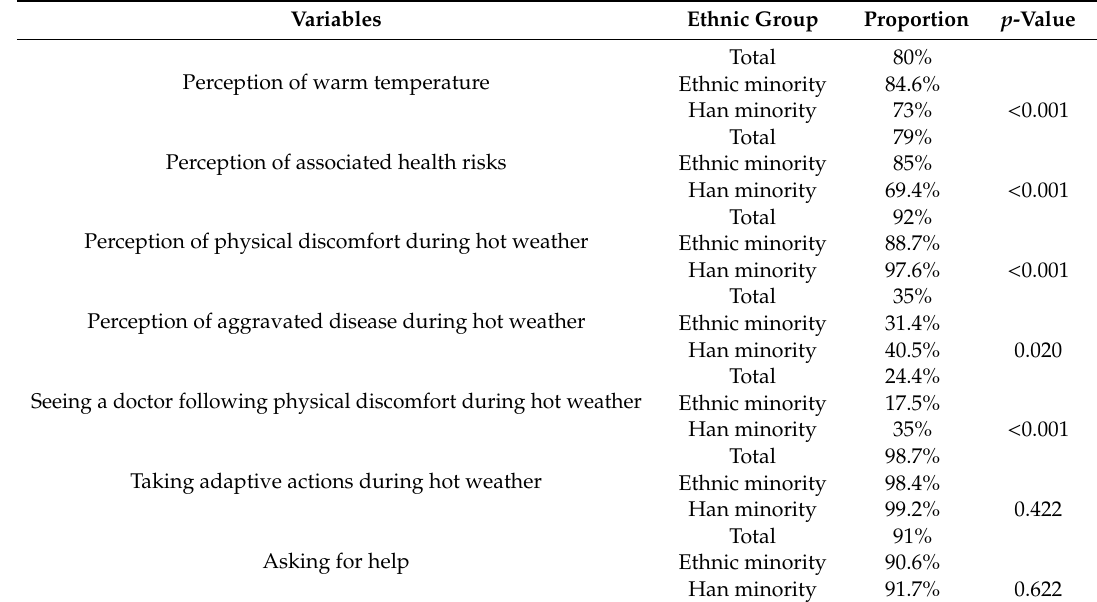
Table 2. Perceptions and responses among the di ff erent ethnic minority